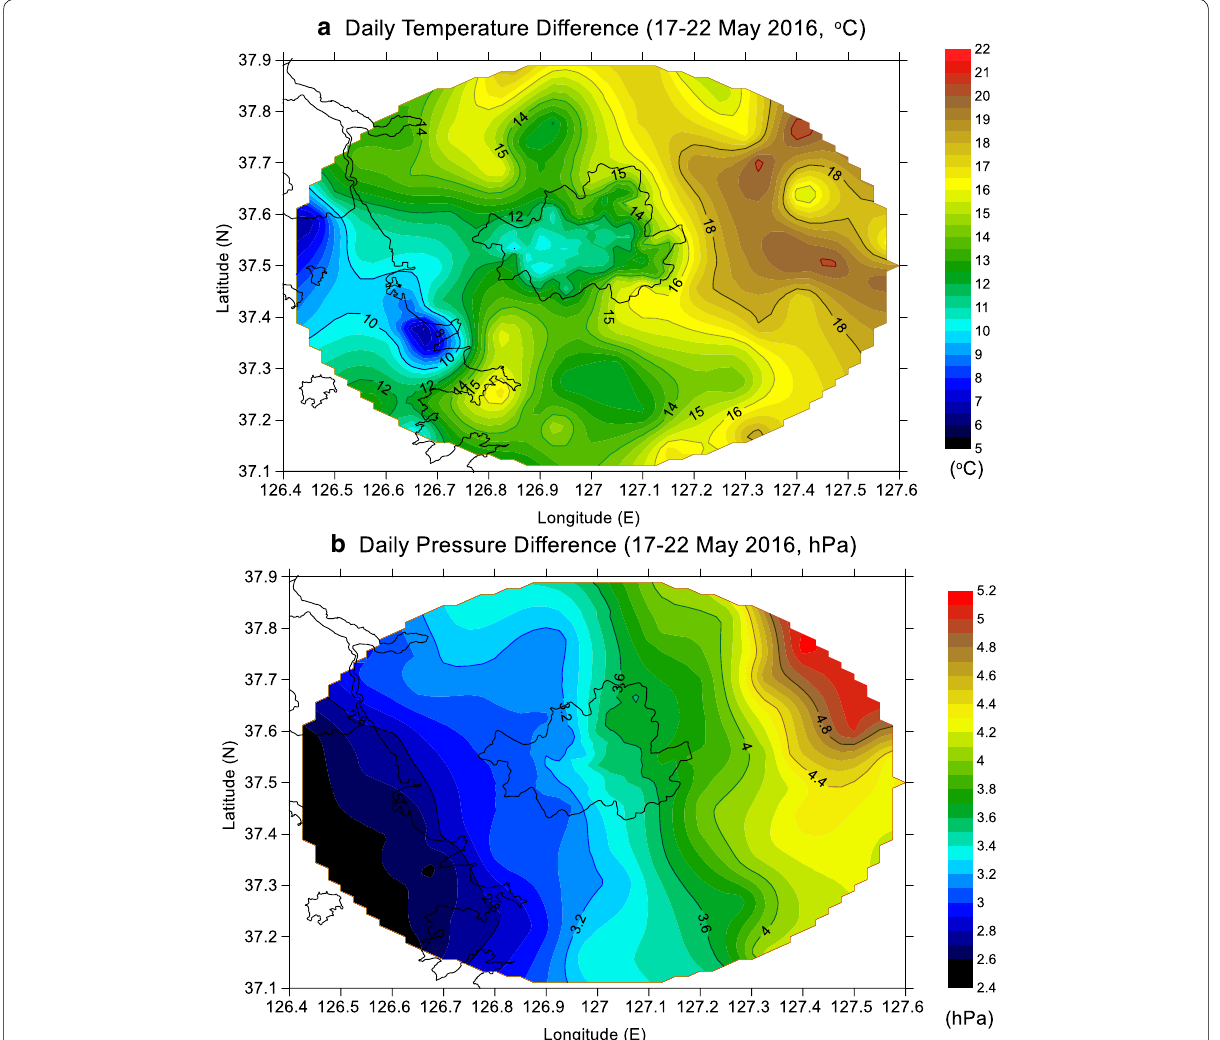
Fig. 4 Horizontal distribution of period mean daily differences of a air temperature and b pressure averaged over 6 days from 17 to 22 May